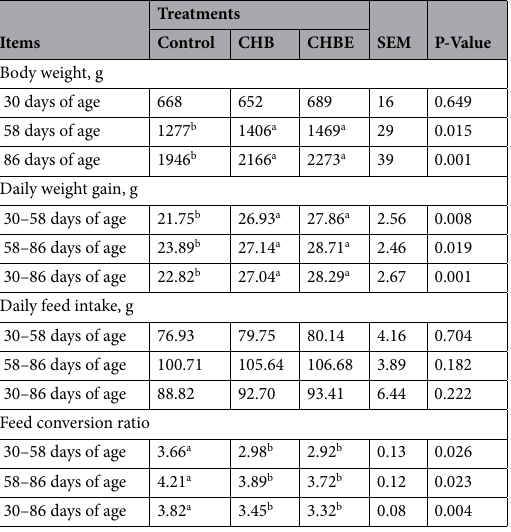
Table 4. Effects of hydroponic barley with or without enzymes on growth performance of growing rabbits. SEM: Standard error of the means (n = 20); CHB: Control diet substituted with 25% hydroponic barley; CHBE: Control diet substituted with 25% hydroponic barley with 0.5 g/kg enzymes. a,b Means within the same row bearing different superscripts differ significantly (P < 0.05).